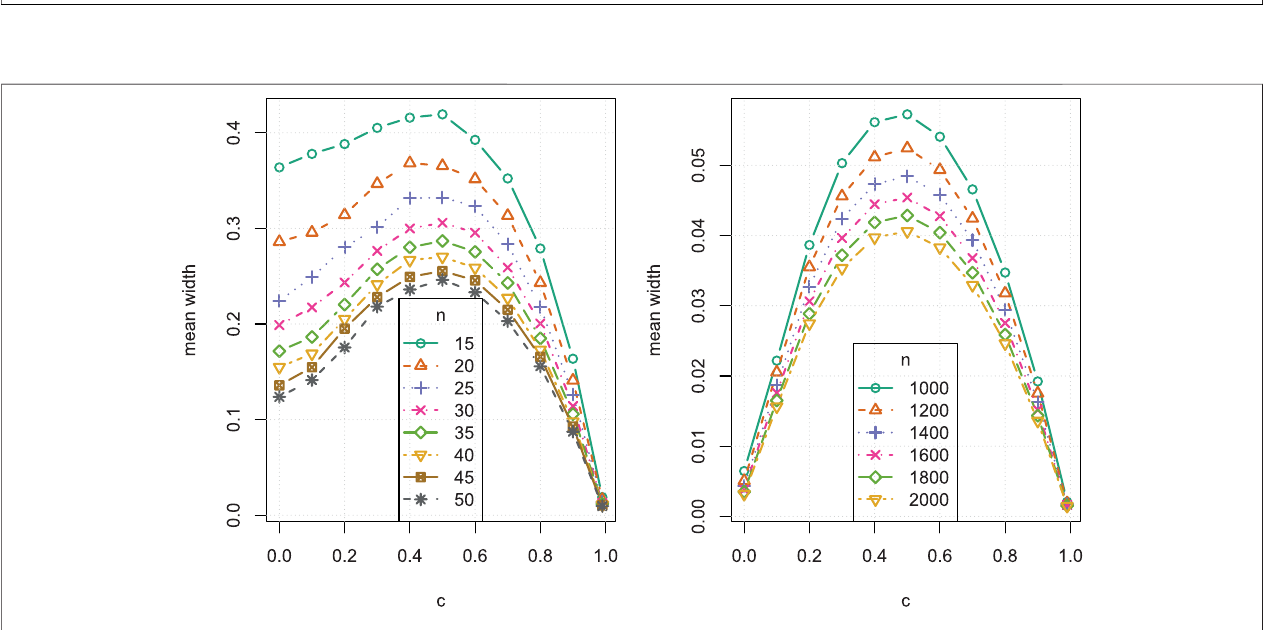
FIGURE7| Estimated coverage probabilityversuscorrelation c,forsmallsamplessizes n (cid:2) 15 , 20 , ... , 50,inMCStudyA.Thesamepatternscanbeobservedfor Studies B and C.